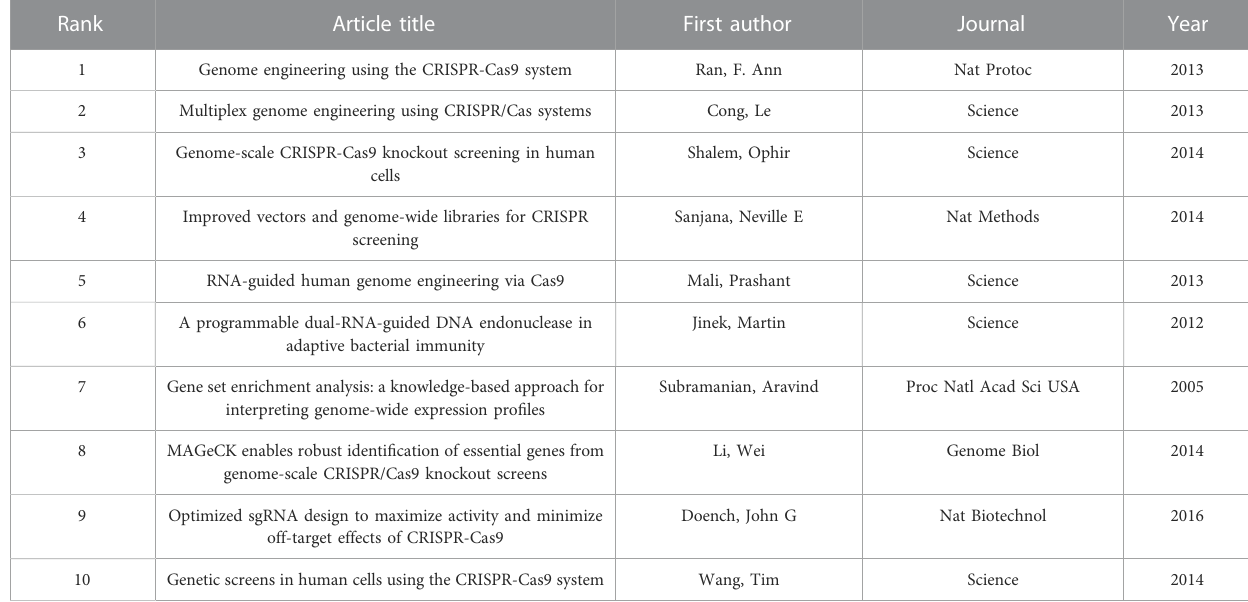
TABLE 3 The top 10 most co-cited references related to CRISPR in cancer.